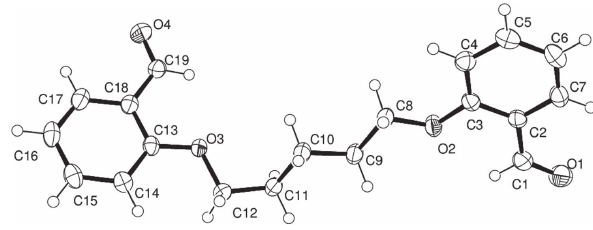
Table 1: Data collection and handling.